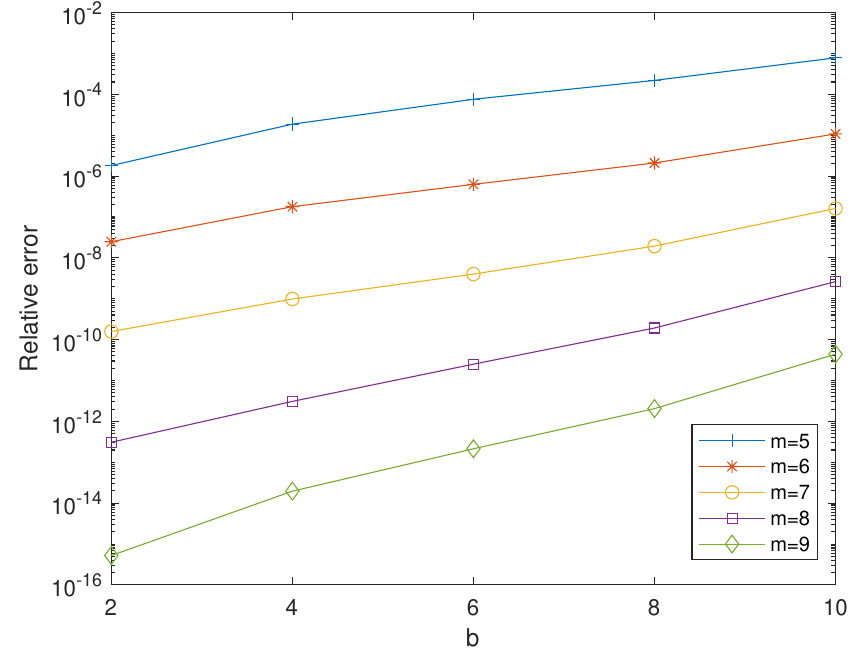
Figure 8. Relative errors for the problem given in Equation (39), for various spline orders ( m 5,6,7,8,9), varying b 2,4,6,8,10 and with a fixed stepsize h =